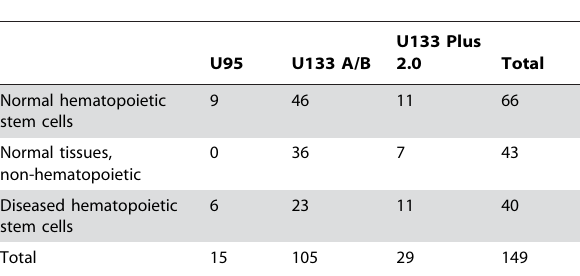
Table 2. Platform and tissue type for various datasets.